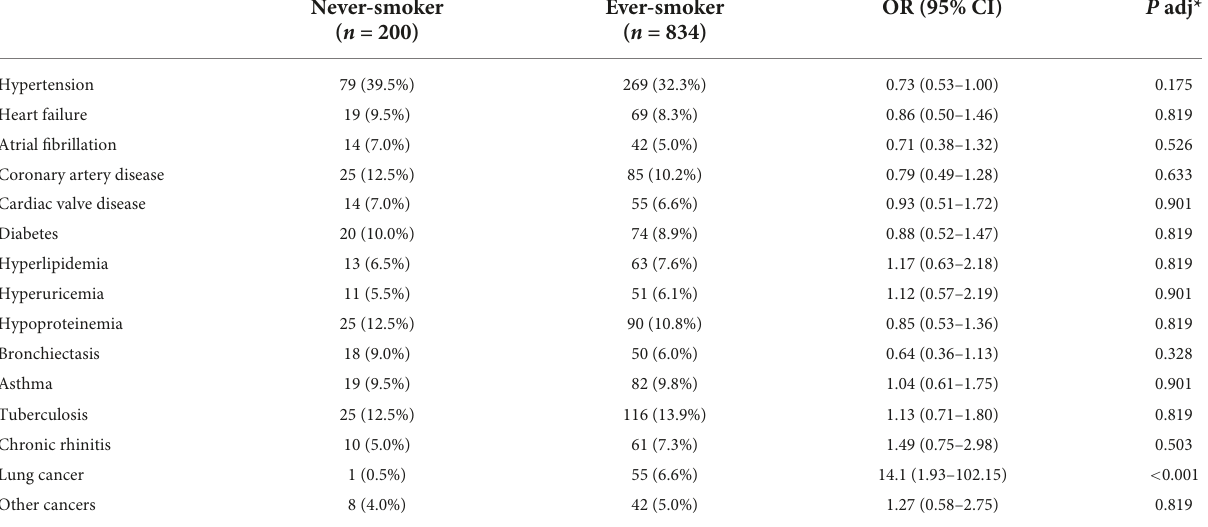
TABLE 3 Association of smoking status with comorbidities in patients with